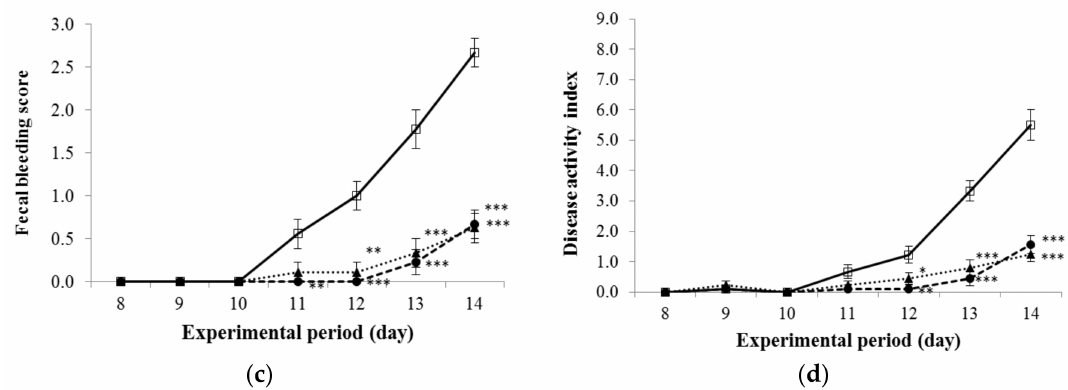
Figure 2. The effect of diet on: ( a ) weight loss; ( b ) stool formation; ( c ) fecal bleeding; and ( d ) the combined disease activity index in dextran sulfate sodium (DSS)-treated mice during DSS treatment (Days 8–14). The diet groups are control (CON, open squares), 10% raw broccoli (RB, filled triangles) and 10% lightly cooked broccoli (CB, filled circles). Data are mean ± SE ( n = 9, except for RB at Day 14, n = 8). *, ** and *** indicate significant difference from DSS/CON ( p < 0.05, p < 0.01 and p < 0.001, respectively).